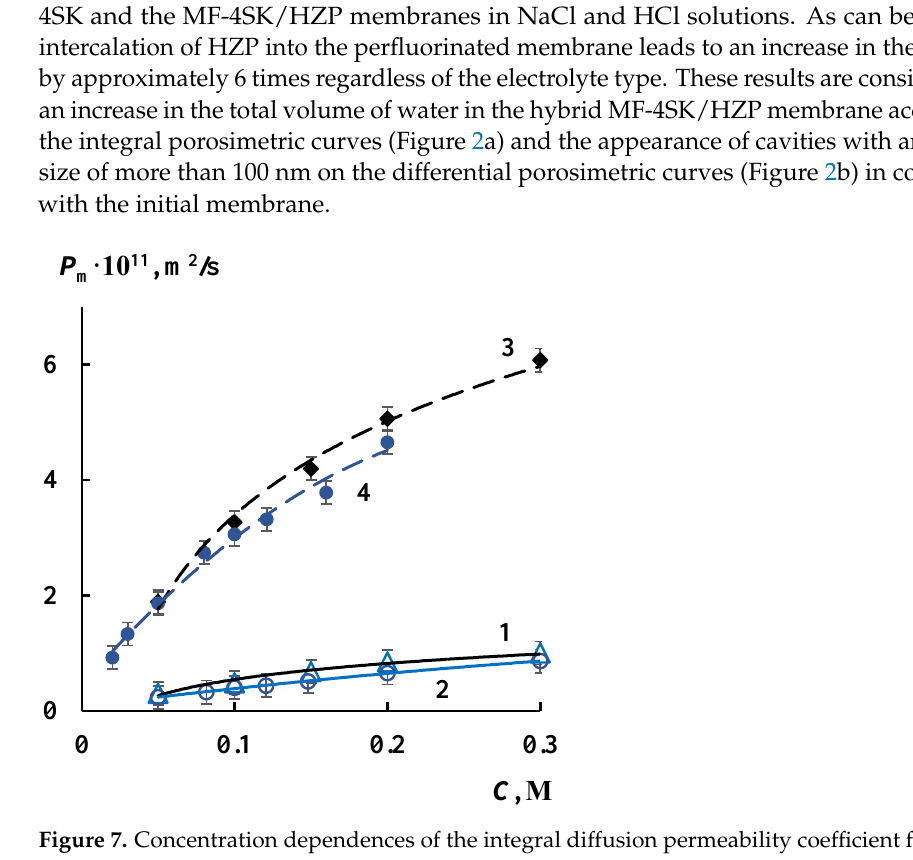
3.20 × 10 − 11 m 2 /s to 7.70 × 10 − 11 m 2 /s at the same experimental conditions. Thus, the diffusion permeability of MF-4SK/SiO 2 membrane is 2.4–3 times higher in comparison with initial membrane regardless of the concentration of the NaCl